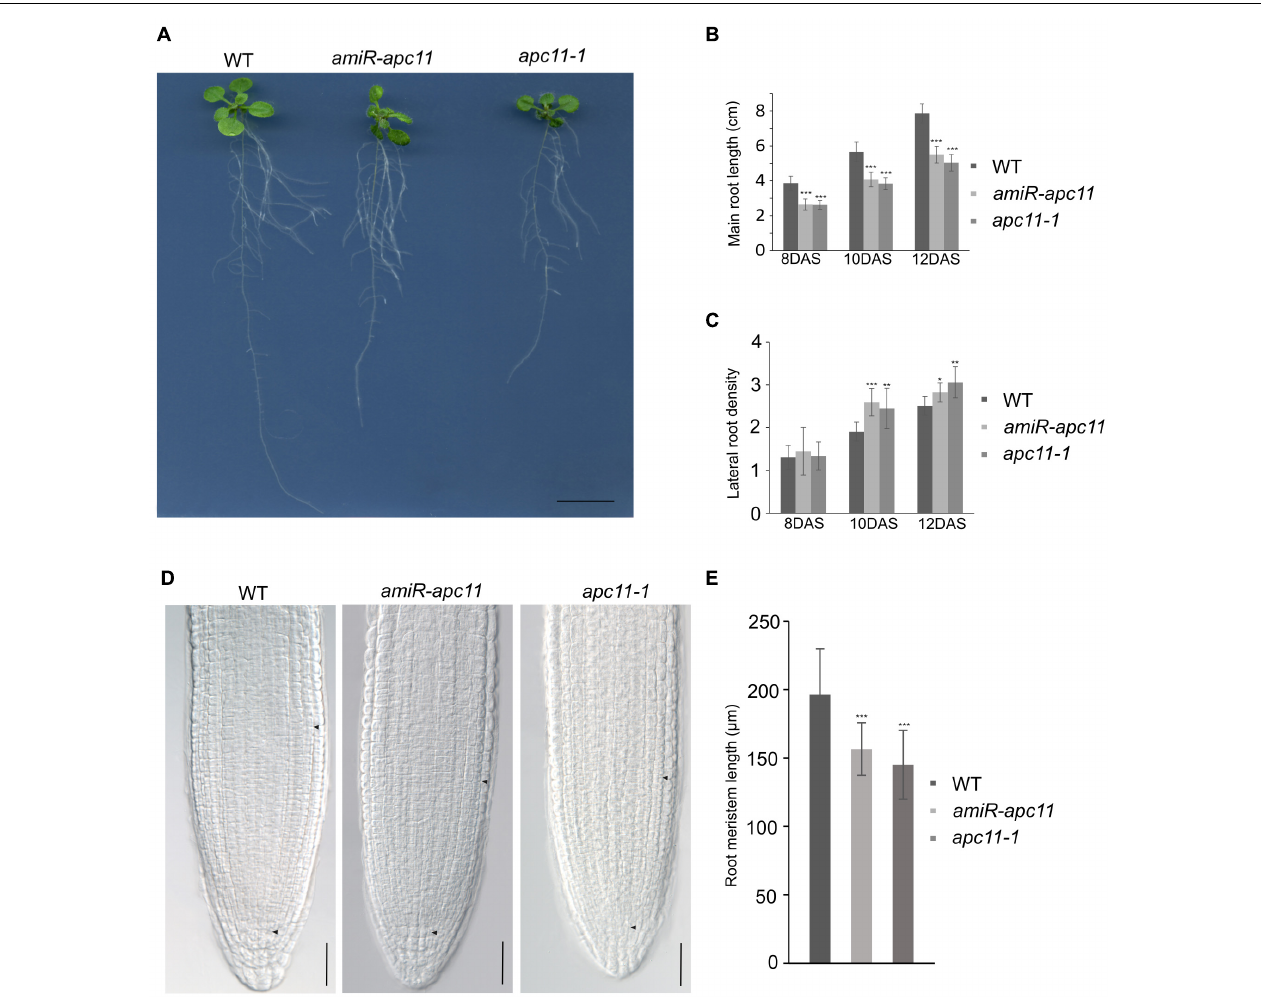
FIGURE 3 | The apc11-1 and amiR-apc11 plants develop smaller root sizes. Root development impairment in apc11 mutant plants observed through time. (A) Representative picture of root length in 12 DAS. Black bar = 1 cm. (B) Measurement of main root length in apc11-1 , amiR-apc11 , and WT plants at 8, 10, and 12 DAS; n = 22 (***P value < 0.001, Student’s t test). (C) Measurement of the lateral root density at 8, 10, and 12 DAS of apc11-1 , amiR-apc11 , and WT plants. n = 13 (*P value < 0.05; **P value < 0.01; ***P value < 0.001, Student’s t test). (D) Representative meristematic region of the main root tip, DIC image at 7 DAS showing a smaller meristem length. Black bar = 30 mM. (E) Measurement of root meristem length at 7 DAS of apc11-1 , amiR-apc11 , and WT plants. n = 15 ± 2 (***P value < 0.001, Student’s t